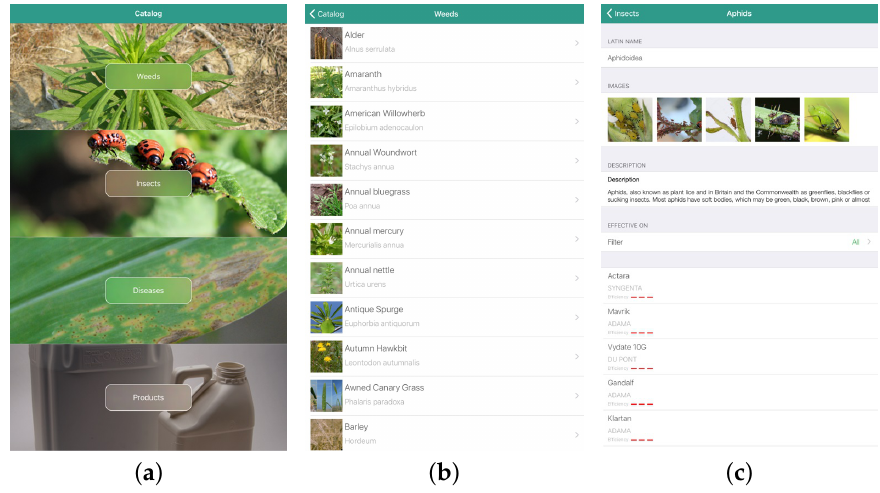
Figure 9. Agrobase: ( a ) Main menu; ( b ) Catalog of diseases and weeds; ( c ) Detailed description and photos of diseases and